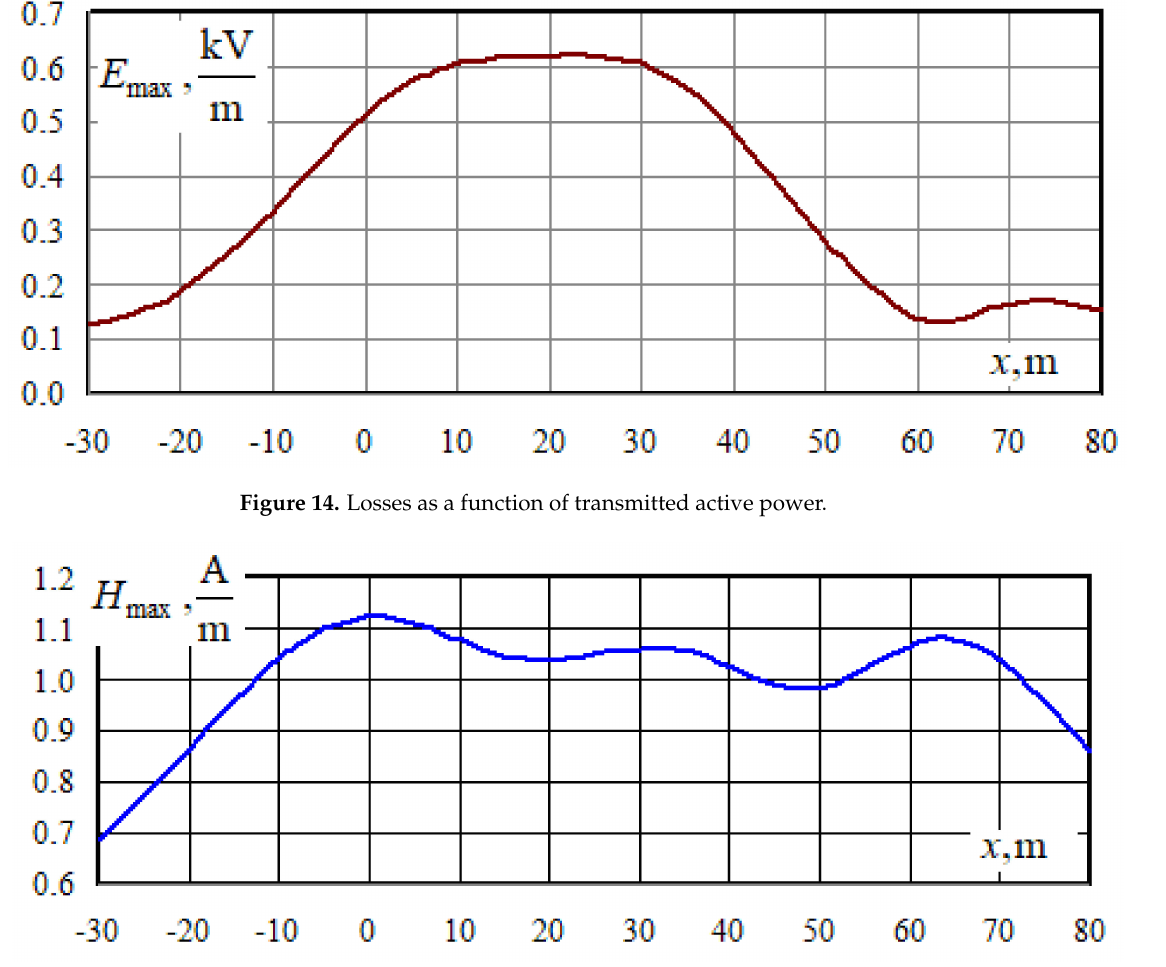
Figure 15. Amplitudes of the magnetic field strength of the transmission line corridor at the beginning of the first section as a function of the coordinate x.